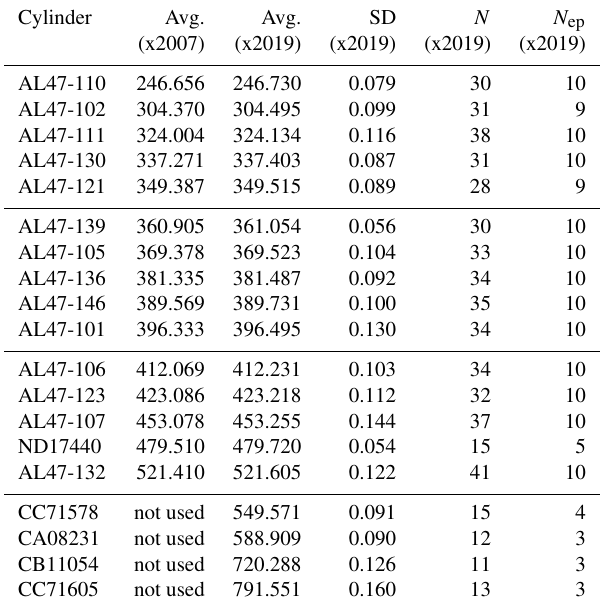
Table 1. Primary standard CO 2 mole fractions (ppm) determined using the NOAA manometer. A lower case “x” is used here to indi- cate that these are mean values determined from manometric mea- surement and have not yet been harmonized into a calibration scale. For X2007 we report the average manometric results from seven episodes (as the mean of the episode averages). For X2019 we av- eraged all valid recoverable data from 1996 to 2017 after correcting and CO 2 loss. Note that primary ND17440 was put into for β CO 2 service in 2010 to replace a standard that was thought to be drift- ing upward. ND17440 was not part of the original X2007